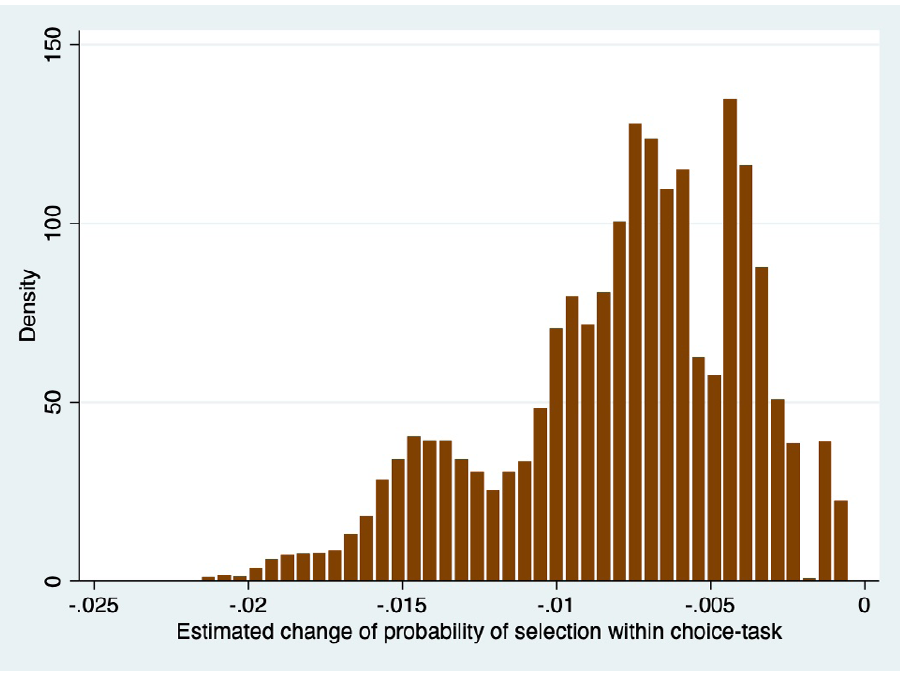
Figure 5. In-sample simulation of selection probabilities for workers’ health and safety certification at 10% price